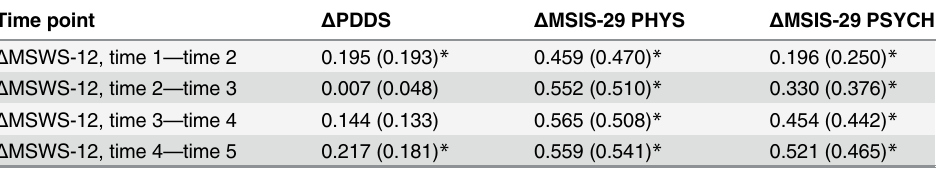
Table 5. Correlation coefficients for change in MSWS-12 scores with change in PDDS and MSIS-29 subscale scores across successive 6-month time periods in the sample of patients with RRMS. Time